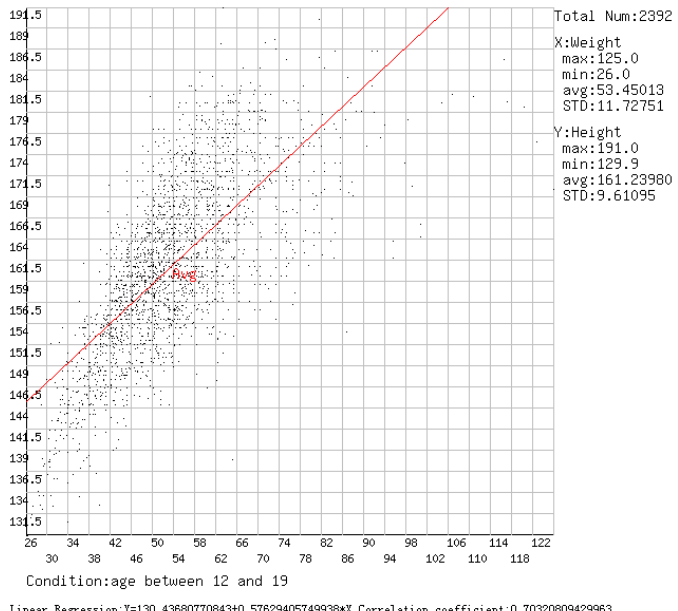
FIGURE 4 . One scatter plot result.